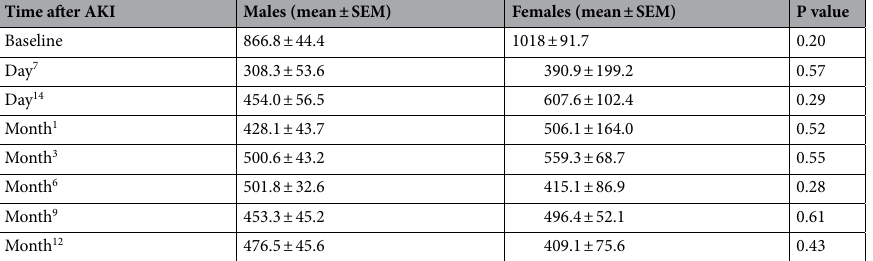
Table 1. Normalized transcutaneous glomerular filtration rate (units = (µL/100 g body weight)/minute) in male and female AKI cohorts throughout the 1 year study. Demonstration of matched model of AKI between male and female cohorts. In the 1 year study, males underwent 25 min of bilateral ischemia; Females underwent 34 min. Measured transcutaneous glomerular filtration rate (tGFR), normalized for weight, demonstrate a matched model of AKI between the male and female cohorts, with no significant differences in tGFR at any of the time points throughout the 1 year study (n =